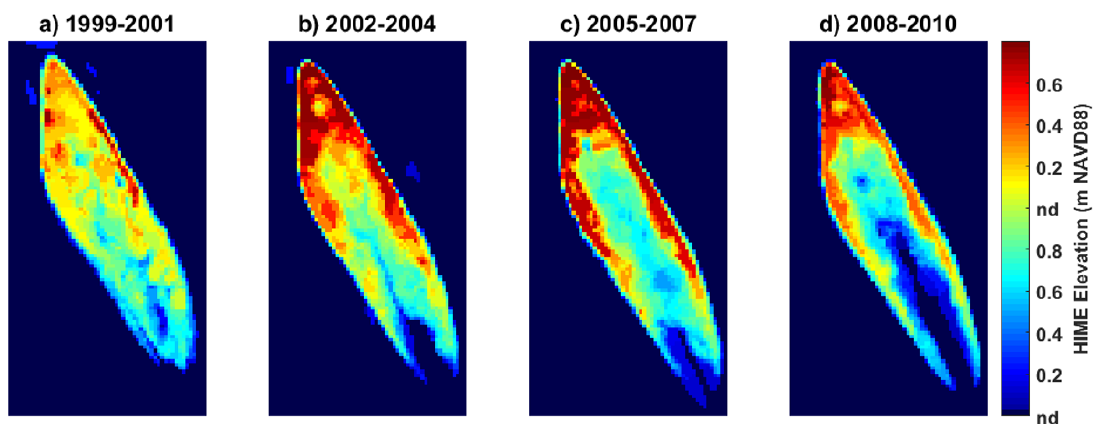
Figure 4. Historical marsh-top elevation models for Pintail Island, resulting from the HIME method applied to RGB Landsat imagery from 1999 – 2010.